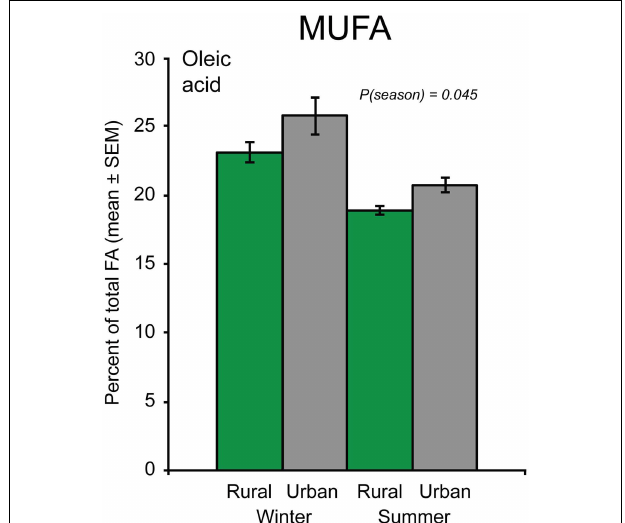
FIGURE 2 | The proportion of the mono-unsaturated fatty acid (MUFA) oleic acid in great tit blood plasma during winter and summer in birds from urban and rural habitats ( N total = 126 ). The significant “season” effect from the model is indicated by the p -value.